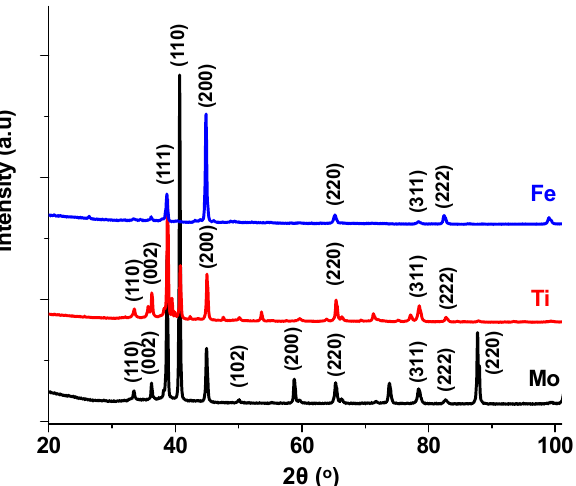
Figure 14. XRD patterns of coatings produced from Al and melamine on different substrates.